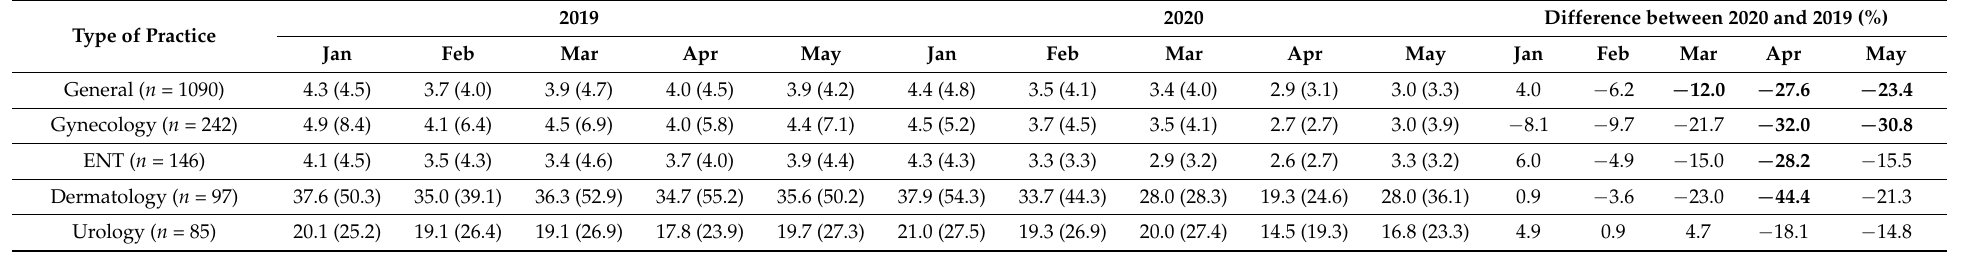
Table 1. Differences by practice type in the number of new cancer diagnoses per practice in Germany between January and May 2020 and January and May 2019. Type of Practice